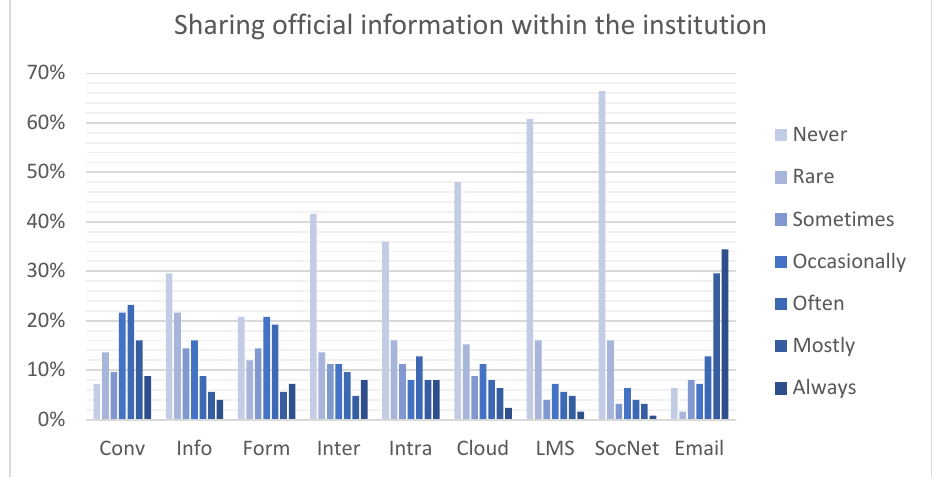
Figure 4. Ways of sharing official information within the institution. (The complete legend is shown in Tables 1 and 2).